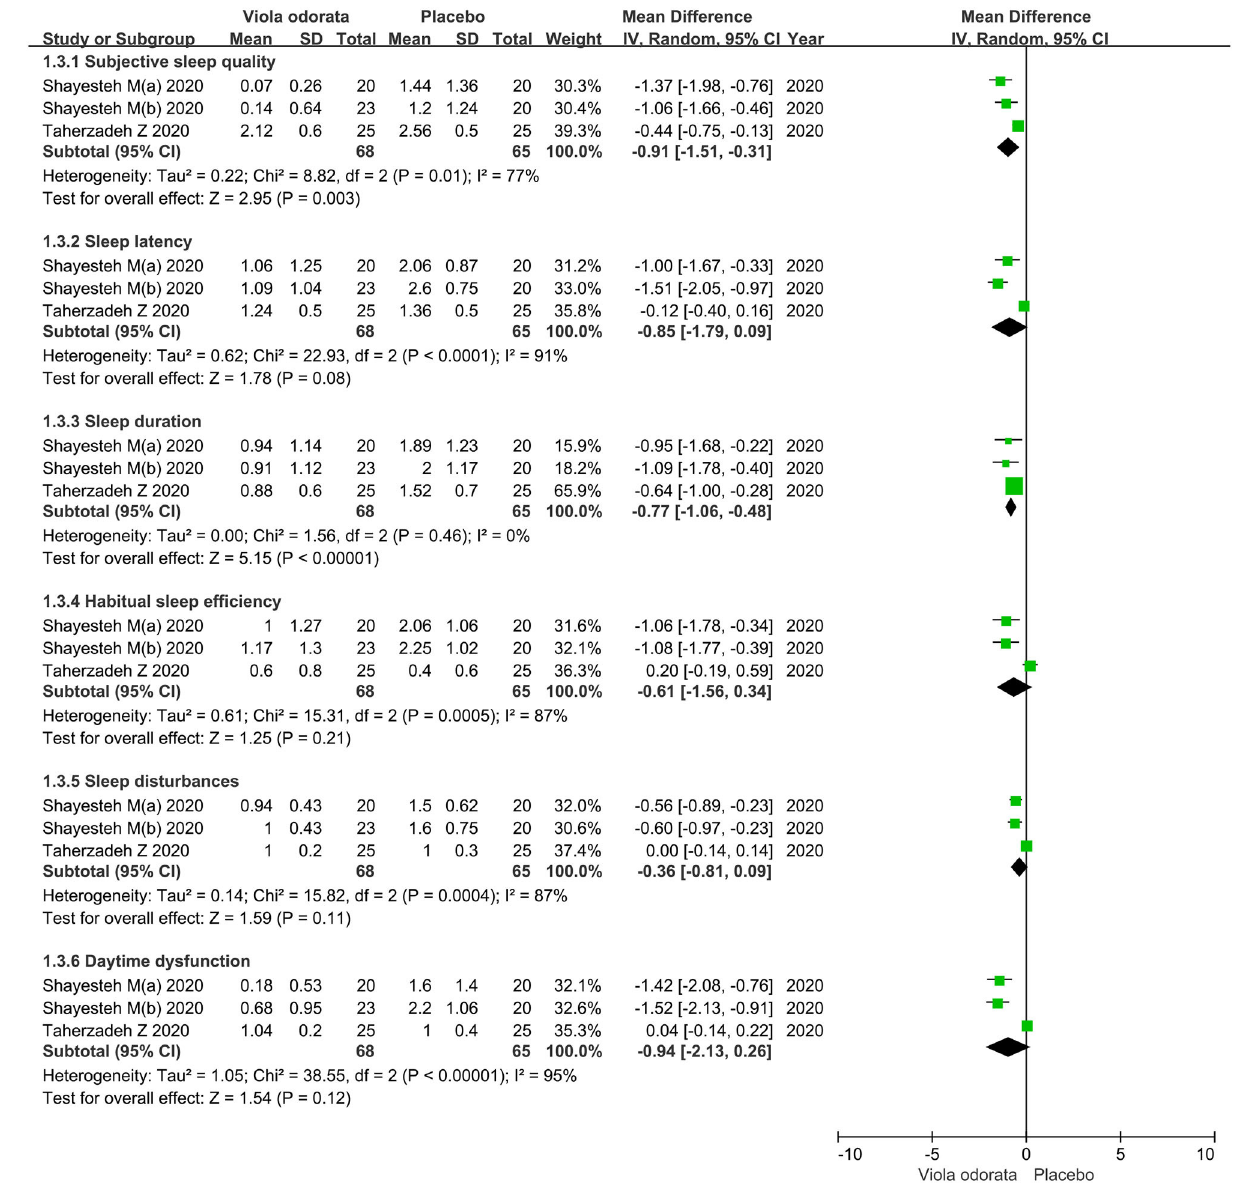
FIGURE 5 | Forest plots showing results in PSQI component score. PSQI, pittsburgh sleep quality index; SD, standard deviation; IV, inverse variance; df, degrees of freedom.